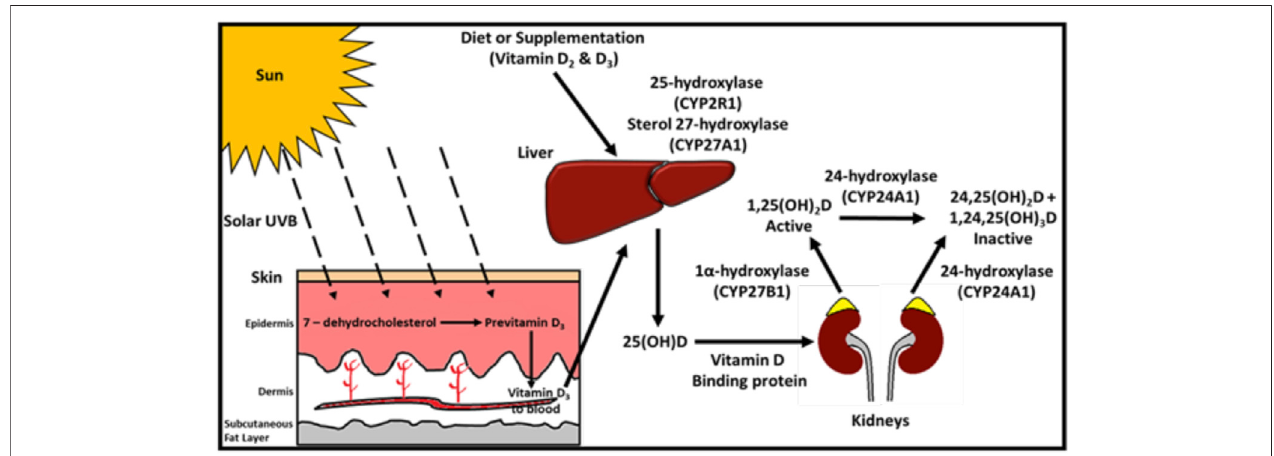
FIGURE 1 | Vitamin D Metabolism: UVB radiation penetrates the skin, converting 7-dehydrocholesterol to pre-vitamin D 3, which is rapidly converted to vitamin D 3 . Vitamin D 3 istransported through thecirculation tothe liver.DietaryvitaminD 2 and D 3 aretransportedfrom theintestine totheliverbychylomicrons(plasma and lymph). Intheliver,vitaminDishydroxylated to25(OH)D,mediatedbyCYP2R1(cytochrome P450[CYP]enzyme).Oncereleasedintothecirculation 25(OH)DbindstovitaminD binding protein and is transported to the kidneys and other tissues. In the proximal tubules of the kidney, 1 α -hydroxylation (CYP27B1) of 25(OH)D results in the production of the active vitamin calcitriol (1.25(OH) 2 D). 1.25(OH) 2 D induces the expression of the enzyme 24-hydroxylase encoded by the CYP24A1 gene which catalyses the conversion of 25(OH)D and 1.25(OH) 2 D to the inactive 24-hydroxylated products, 24.25(OH) 2 D and 1,24,25(OH) 3 D respectively. Reproduced with permission from: Grif fi n TP, Bell M, Robinson S et al. (2017) Vitamin D and vitamin D de fi ciency in Ireland - a call to action. UPDATE Endocrinology and